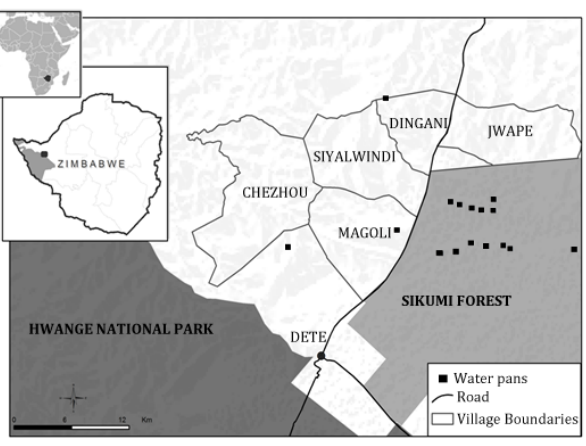
Fig. 1. Study area, villages adjacent to Hwange National Park and Sikumi Forest,